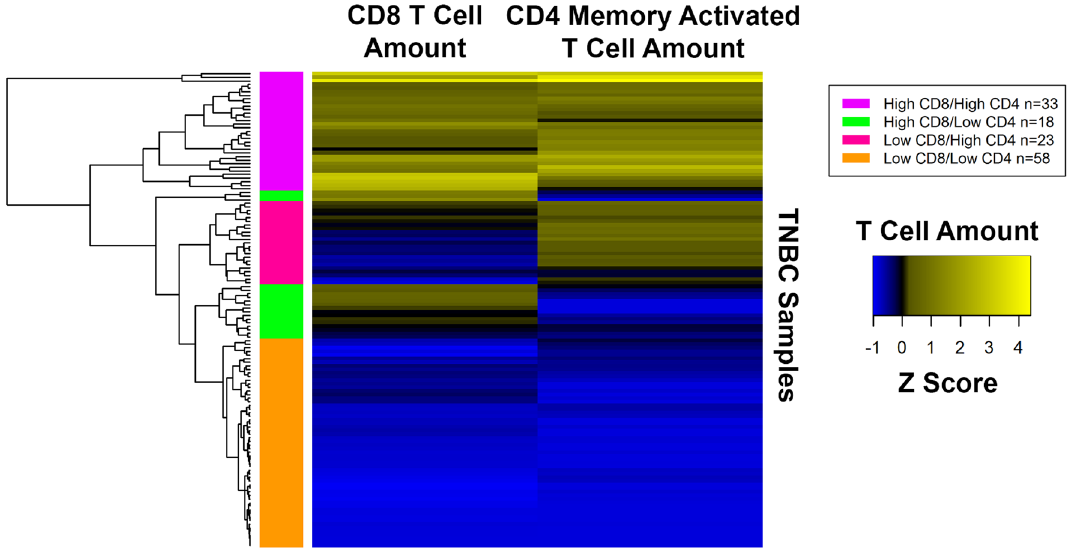
Figure 5. Hierarchical clustering of CD8 T cell and CD4 memory activated T cell quantities in TCGA TNBC samples. RNA sequencing (RNA-Seq) gene expression data was analyzed with CIBERSORT to quantify the amount of different T cells in the TCGA TNBC samples. Hierarchical clustering of these quantities after normalization is shown in the heatmap. Clusters of samples enriched in CD4 memory activated T cells (deep pink cluster), CD8 T cells (green cluster), both cell types (magenta cluster), or neither cell type (orange cluster) are represented. Image generated with R’s (4.0.2) (https ://www.R-proje ct.org) 35 gplots package (3.0.4) (https :// CRAN.R-proje ct.org/packa ge=gplot s) 36